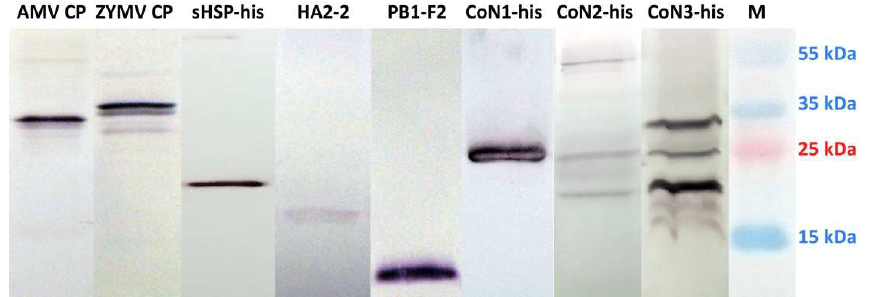
Figure 2. Western blot analyses of particular proteins produced in N. benthamiana . AMV CP, ZYMV CP, CoN2-his and CoN3-his—crude leaf extracts, HA2-2 and PB1-F2—crude root extracts, sHSP-his and CoN1-his—IMAC-purified products, M: PageRuler Plus Prestained Protein Ladder (Thermo Scientific, Waltham, MA, USA).